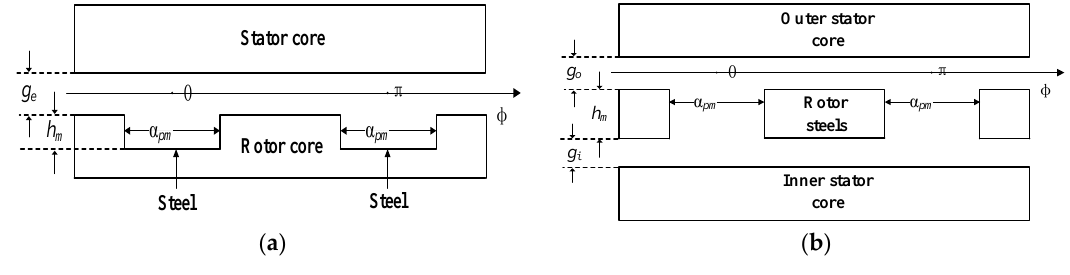
Figure 3. Air gap structures of the ( a ) BDFRM motor and ( b ) DSFM motor.